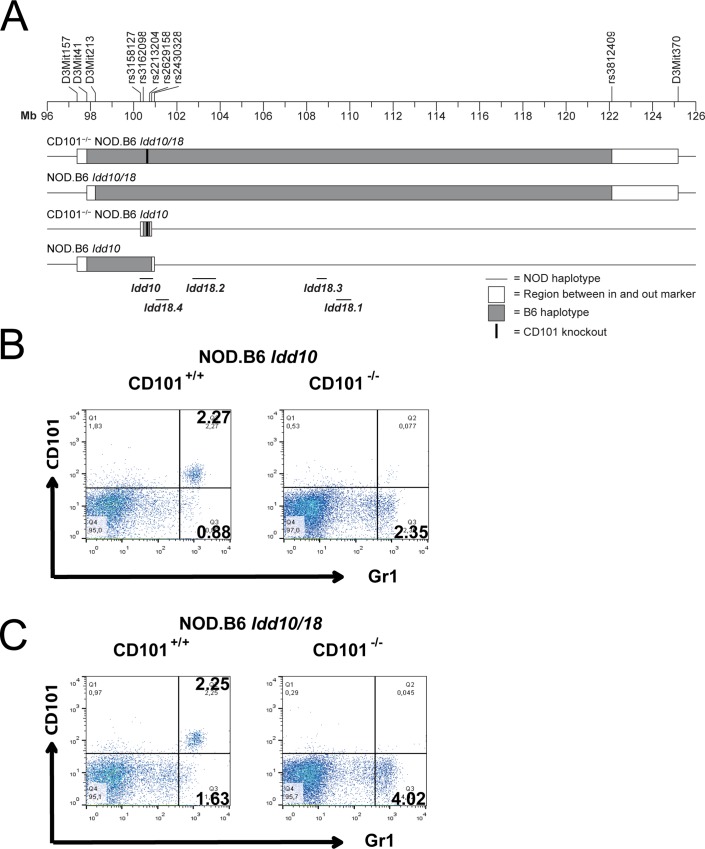
Deletion of Cd101 exon 1 leads to a loss of protein expression.Representation of the Idd10 and Idd18 regions and the NOD congenic strains used in this study (A). Lack of CD101 expression in CD101−/− NOD.B6 Idd10 (B) and CD101−/− NOD.B6 Idd10/18 mice (C). CD11b-positive cells in the spleens of CD101−/− NOD.B6 Idd10 (B) and CD101−/− NOD.B6 Idd10/18 mice (C) as well as CD101-expressing control littermates were evaluated for their CD101-expression by flow cytometry. Representative FACS dot plots are displayed.